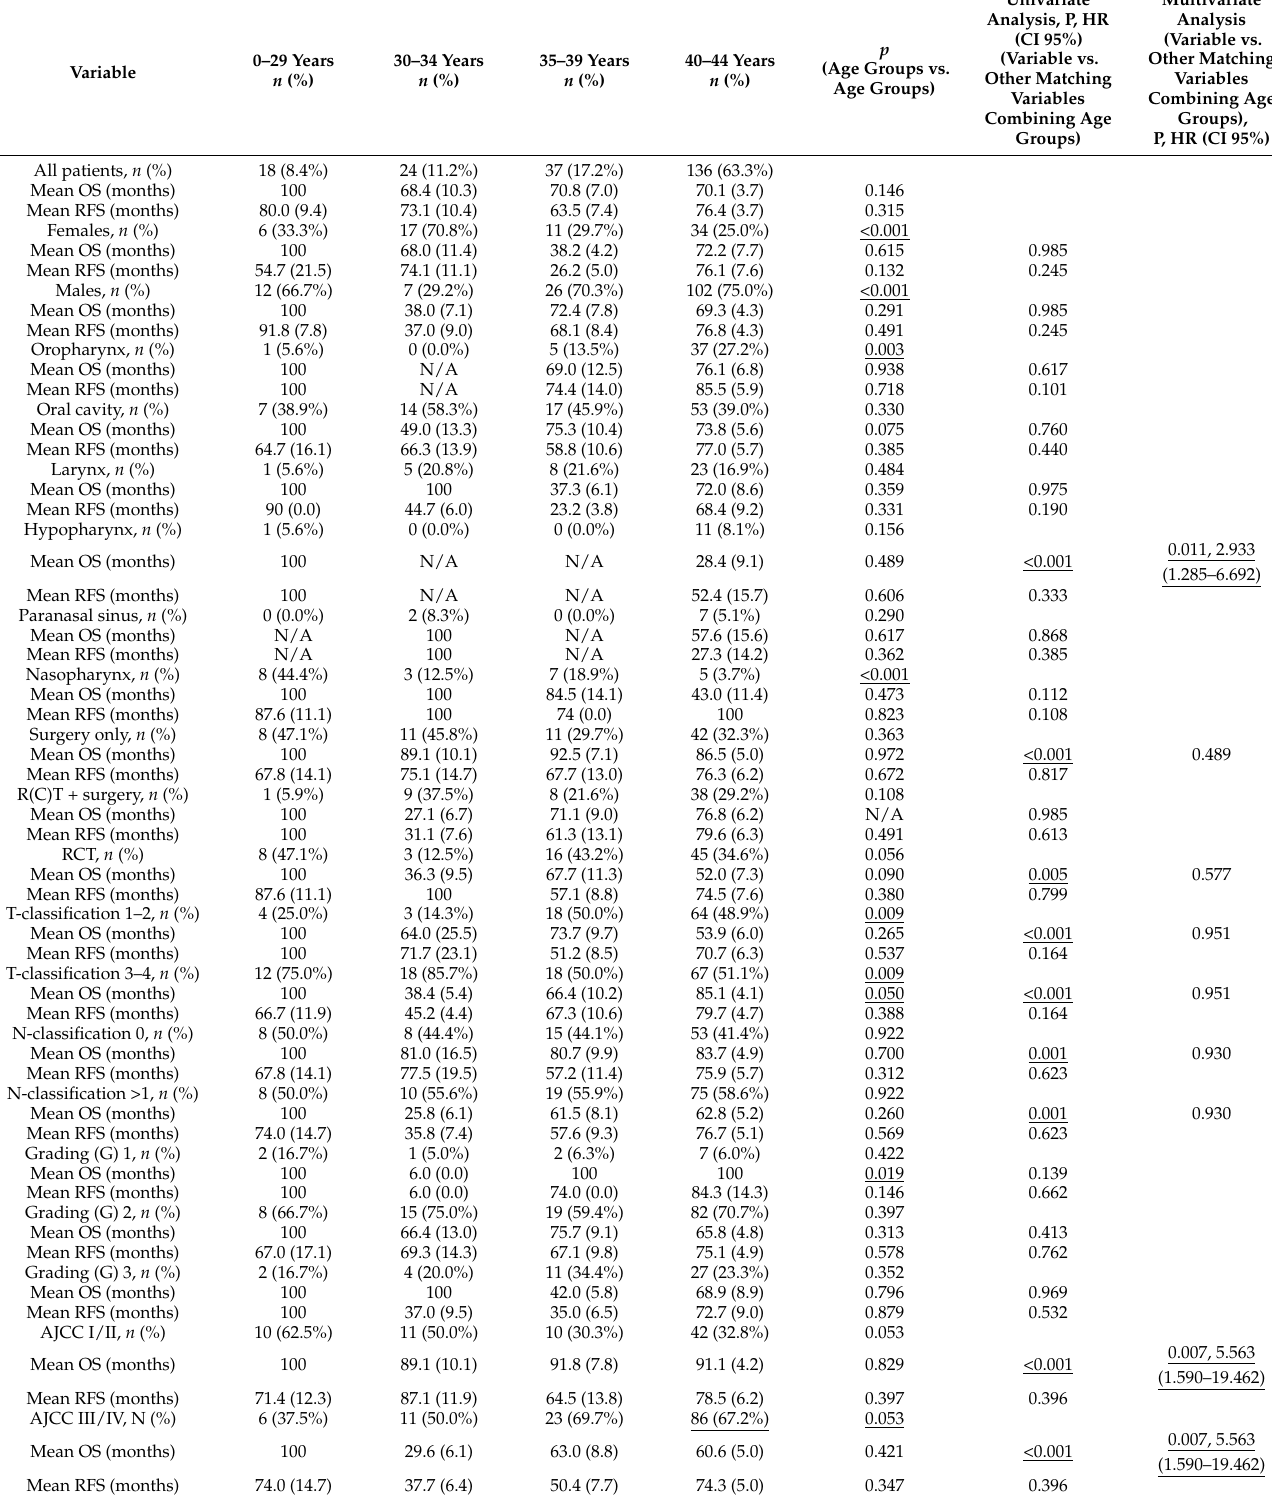
Table 4. Analysis of clinicopathologic variables associated with overall survival (OS) and relapse- free survival (RFS) in the aged-categorized patient group under 45 years. SCC: squamous cell carcinoma; RCT: radio(chemo)therapy; T-classification: tumor classification; N-classification: lymph node classification; SD: standard deviation; HR: hazard ratio; CI: confidence